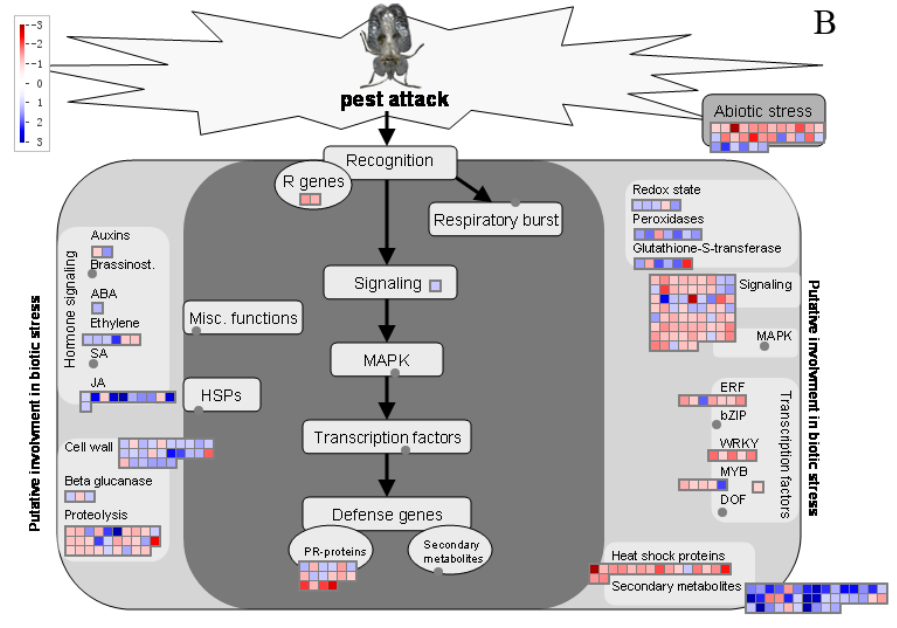
Figure 3. MapMan visualization of DEGs in the P. acerifolia response to C. ciliata feeding damage. The up- and down-regulated genes are indicated in red and blue colors, respectively. The log 2 FC (treatment TPM/mock TPM) are shown in the scale bars. A, 24-hour treatment. B, 48-hour treatment.